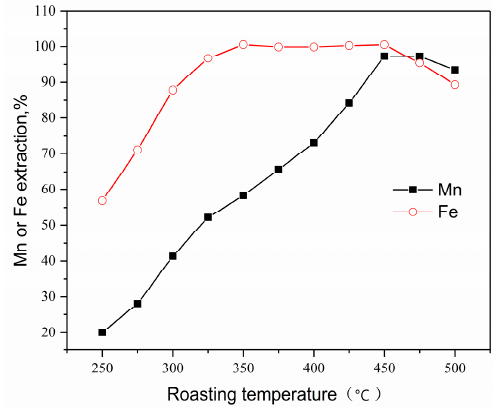
Figure 6. The effect of roasting temperature on the extraction of iron and manganese from PAR.